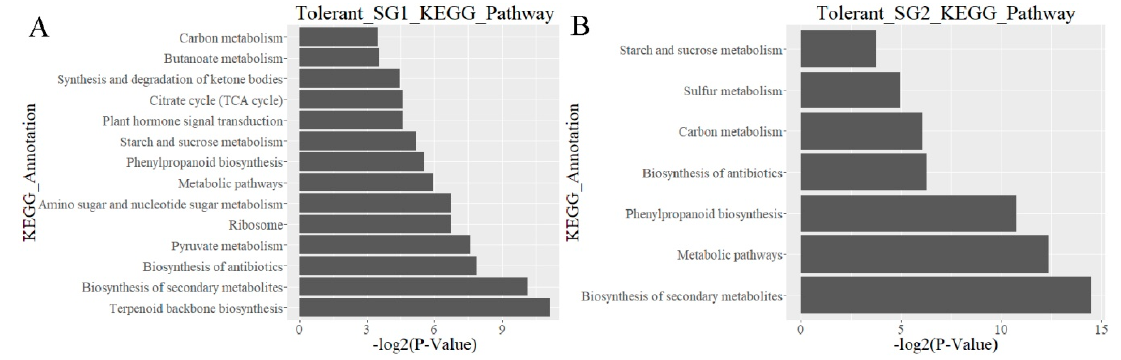
Figure 6. Enrichment analysis of differentially expressed genes of the KEGG pathway for Al-tolerant varieties. ( A ). Enrichment analysis for Al-tolerant variety in SG1 ( Indica ); ( B ). Enrichment analysis for Al-tolerant variety in SG2 ( Japonica ).